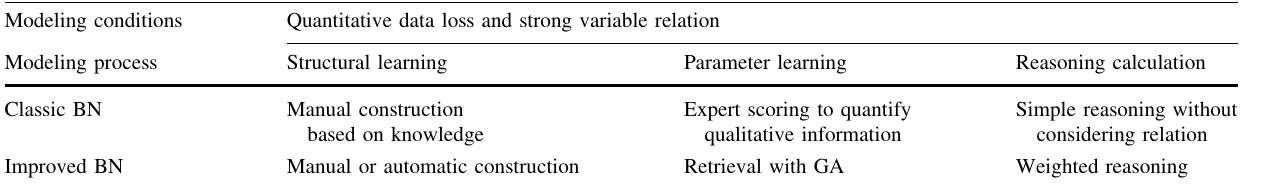
Table 2 Comparison between the improved Bayesian network and classic Bayesian network models Modeling